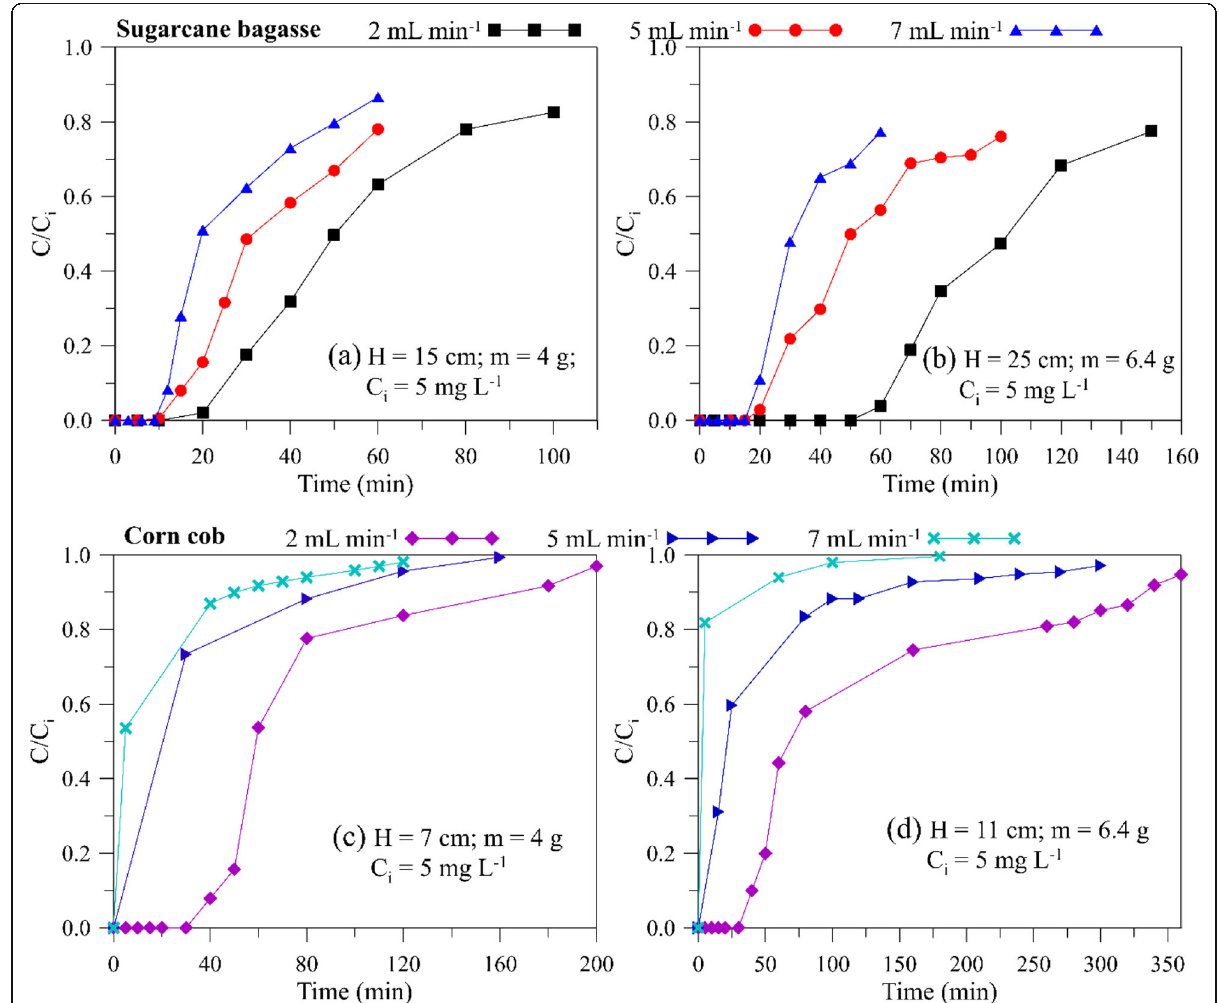
Fig. 3 Influence of flow rate on the breakthrough curve of the SMX adsorption with an initial concentration of 5 mg L −